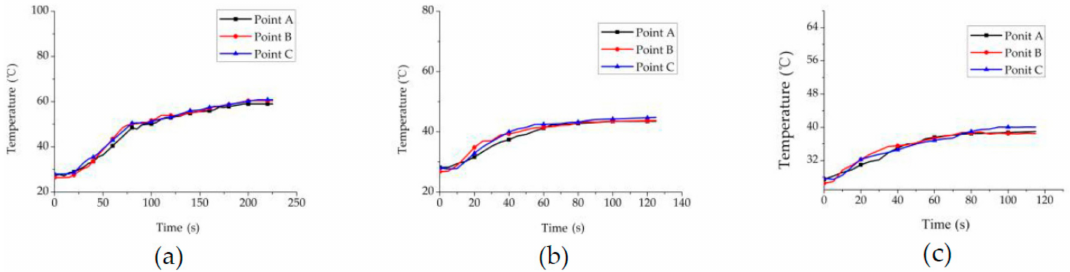
Figure 10. Temperature rise at point A (45.6, 150, 85), point B (54.6, 150, 85), and point C (63.6, 150, 85) when the microwave power was 200 W. ( a ) temperature rise at a velocity of 60 mL/min; ( b ) temperature rise at a velocity of 120 mL/min; and ( c ) temperature rise at a velocity of 180